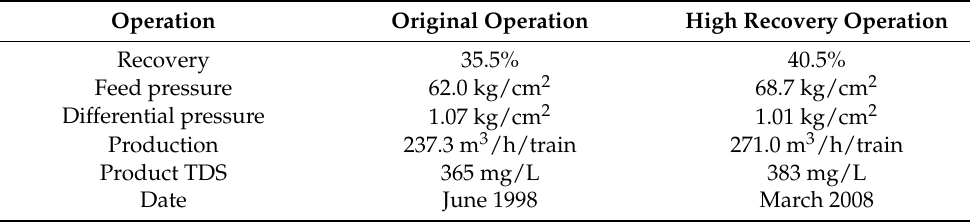
The Ras Al Khair SWRO plant (capacity of the first pass: 899 m 3 /h × 16/train ×